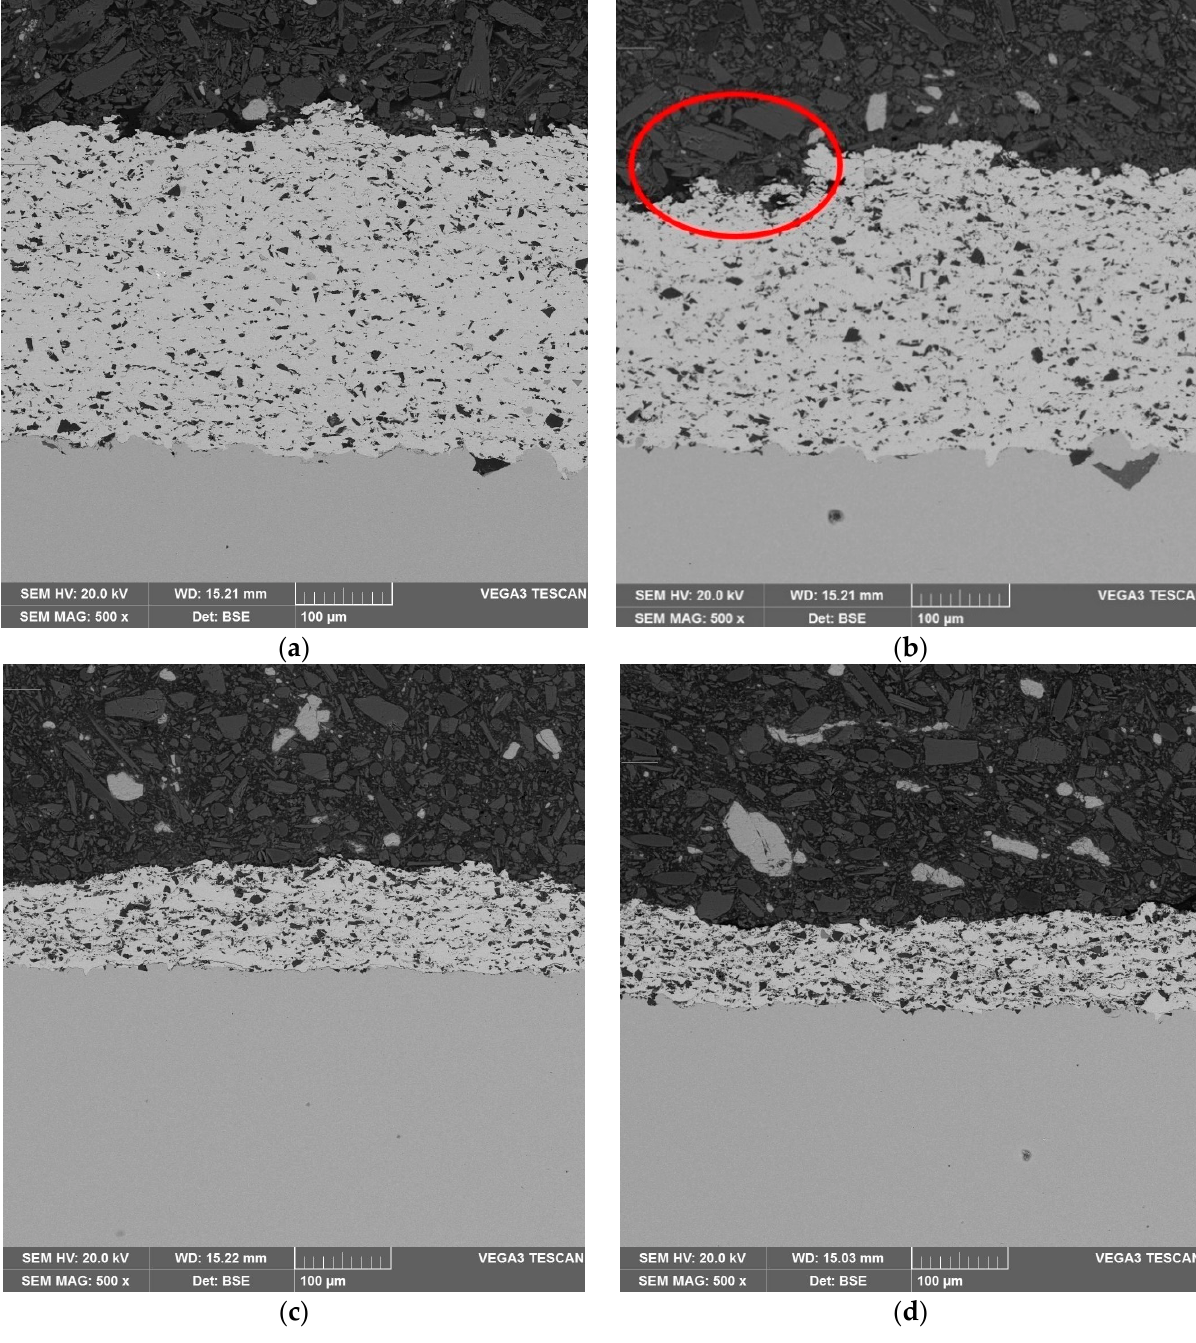
Figure 6. SEM (BSE) images of ECu ( a , b ) and SCu ( c , d ) coatings cross-section without ( a , c ) or with ( b , d ) additional SiC layer. Red circle mark the torn off piece of coating.